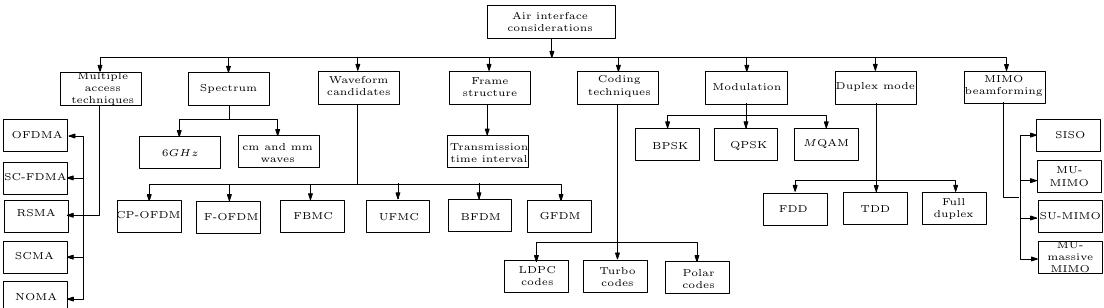
Figure 7. Classification of air interface design considerations for 5G